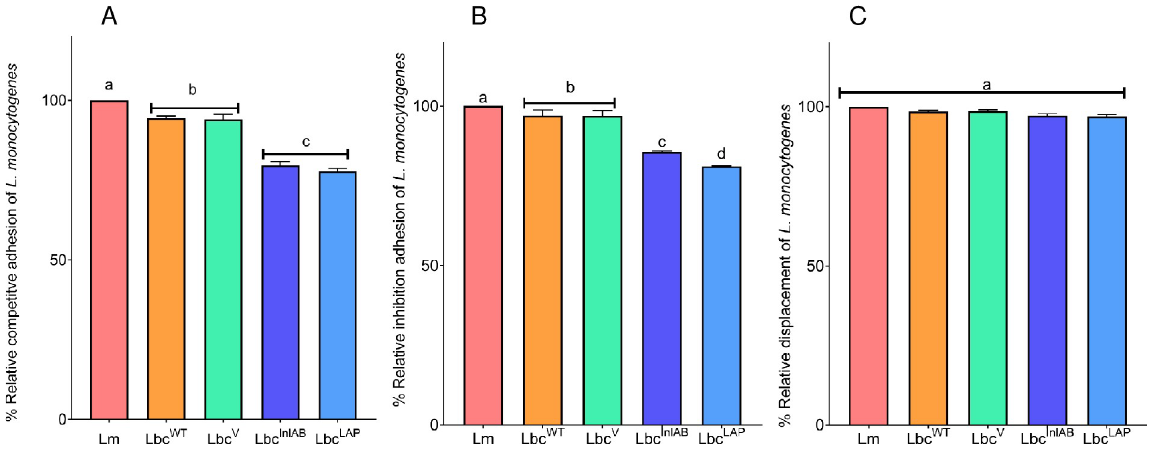
Fig 2. Competitive exclusion of Listeria monocytogenes (Lm) adhesion to Caco-2 cells by L . casei strains (Lbc WT , Lbc V , Lbc InlAB and Lbc LAP ), analyzed by three different exclusion mechanisms. ( A ) Competitive adhesion: Caco-2 cells were exposed to L . casei strains with Lm simultaneously, ( B ) Inhibition of adhesion: Caco-2 cells were pre-exposed to L . casei strains for 1 h before infection with Lm, and ( C ) Displacement of adhesion: Caco-2 cells were infected with Lm for 1 h before L . casei strains (1 h). Adhesion of Lm alone to Caco-2 cells was presented as 100% and percentage adhesion was calculated relative to that. Data are averages of three experiments run in duplicates. Error bars are standard deviations of averages of the three independent experiments. Bars marked with different letters (a, b, c, d) indicate significant difference at p <